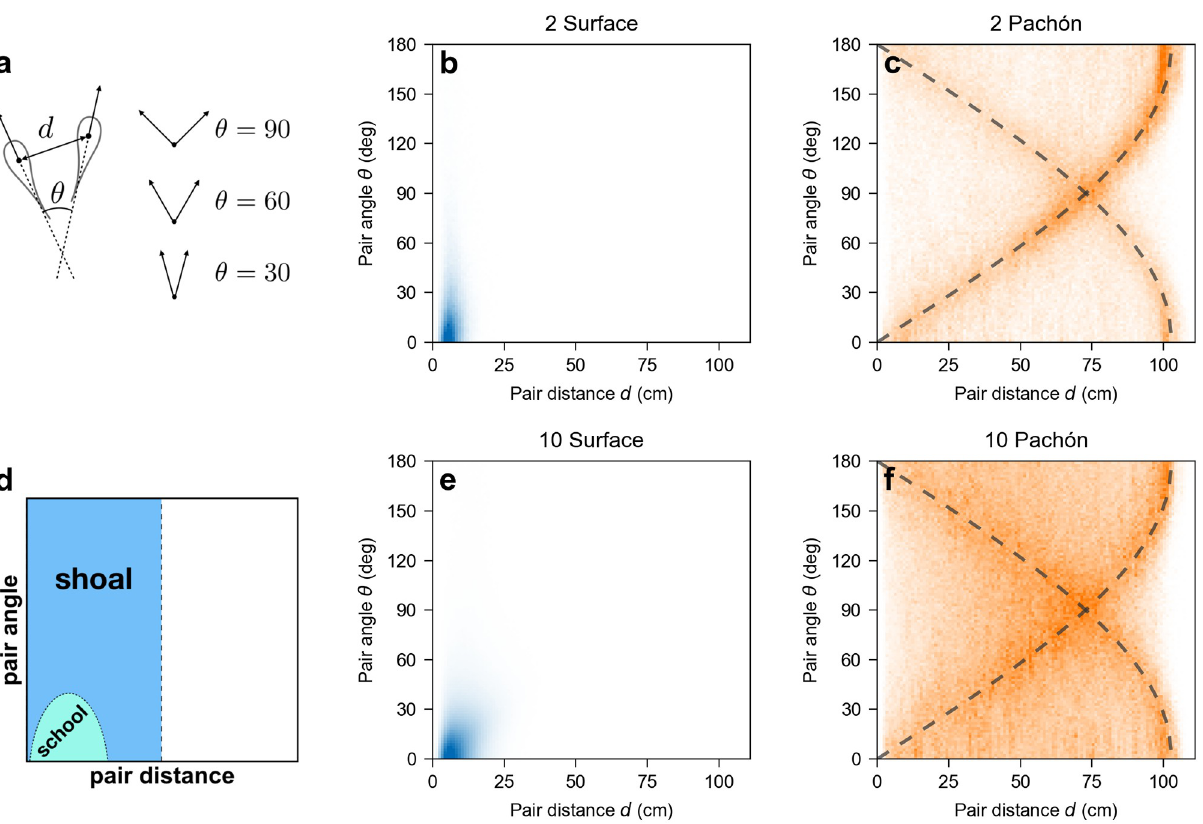
Fig 5. (a) Definition of the pair distance d and pair angle θ between two fish. (b, c, e, f) Joint probability density of pair distance and pair angle for all pairs of fish. (d) Qualitative expectations for schooling and shoaling fish. For a school, short distances and small relative angles yield a peak in the bottom left corner. For a shoal, short distances and a wide range of angles yield a vertical band on the left side. For a group that does neither, we expect the distribution to spread over the entire available range of distances and angles. (b, e) Groups of surface fish exhibit close proximity and tight angles indicative of strong schooling. (c, f) Groups of Pacho´n cavefish exhibit neither schooling nor shoaling. The dashed lines show the expectation for fish following the wall. Comparable probability densities are shown for all group sizes and populations (including Tinaja and Molino) in S1